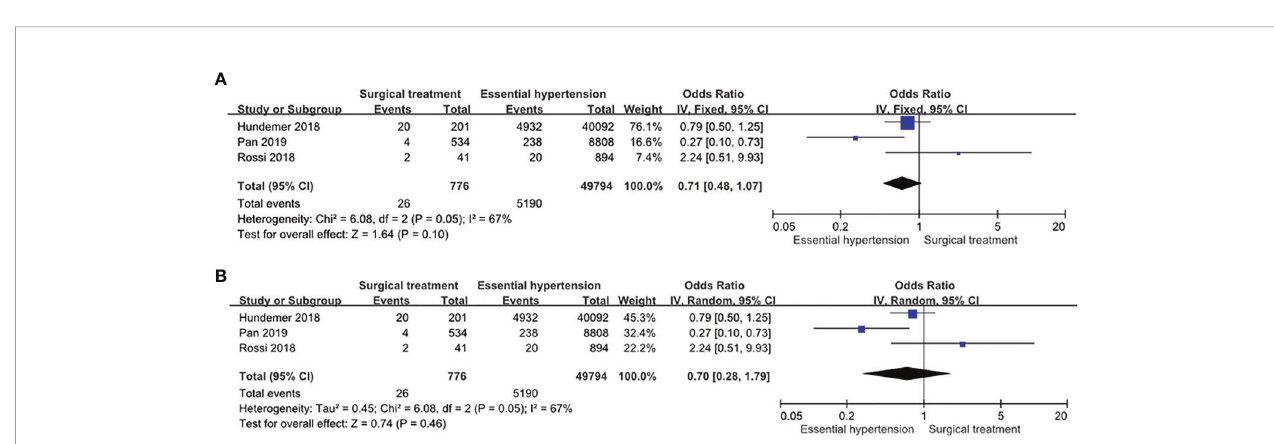
FIGURE 4 | Forest plot of NOAF in PA patients receiving adrenalectomy vs EH patients. Forest plots for the fi xed effects model (A) and random effects model (B) . CI, con fi dence interval; OR, odds ratio; NOAF, new-onset atrial fi brillation; PA, primary aldosteronism; EH, essential